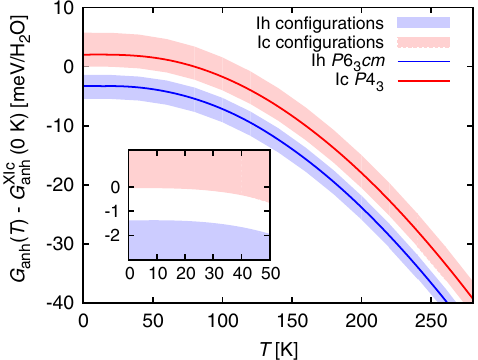
FIG. 4. G for H 2 O as a function of temperature. The solid anh blue and red lines indicate results for Ih P 6 3 cm and Ic P 4 3 simulation cells containing 96 and 64 molecules, respectively. The light blue and light red areas indicate the spread in free energies arising from the different Ih and Ic proton orderings. 2 anh j